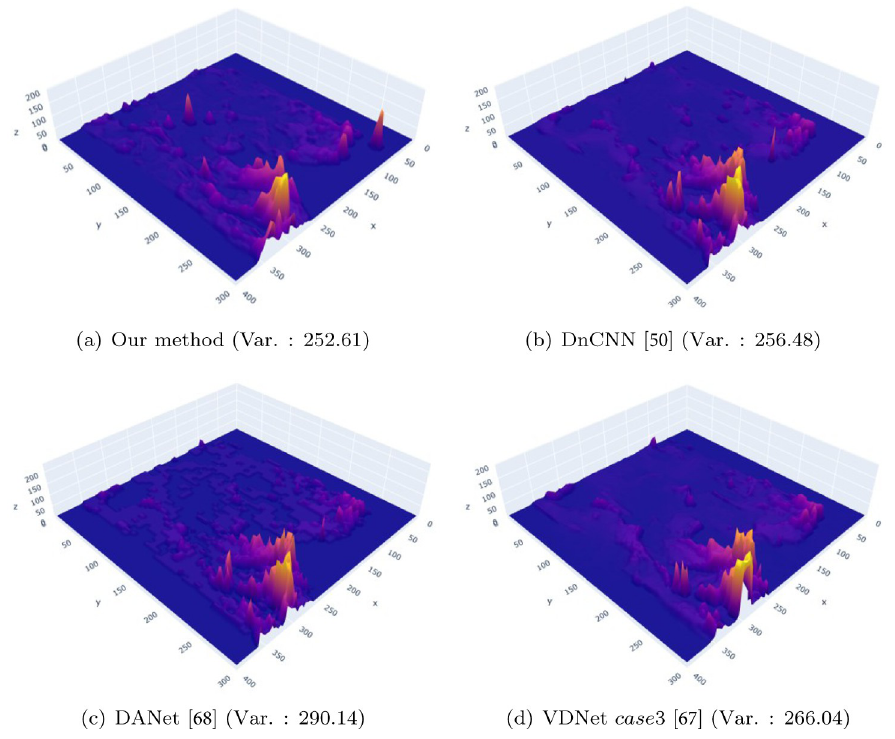
Fig 25. Difference in acceleration map between frames (at frame 160). The chart ranges for each method are as follows: our method, DnCNN, and VDNet ! 0( ■ ) � 180( ■ ), DANet ! 0( ■ ) � 200( ■ )). (a) Our method (Var.: 252.61),